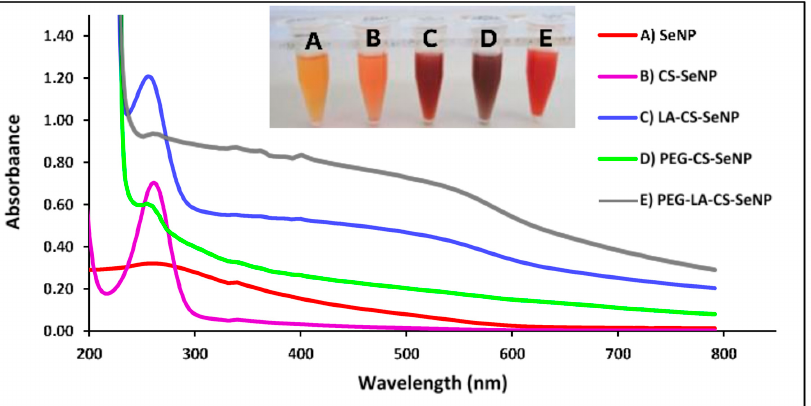
Figure 3. UV-visible spectra of ( A ) SeNPs, ( B ) CS-SeNPs, ( C ) LA-CS-SeNPs, ( D ) PEG-CS-SeNPs, and ( E ) PEG-LA-CS SeNPs and color changes (inset) observed during